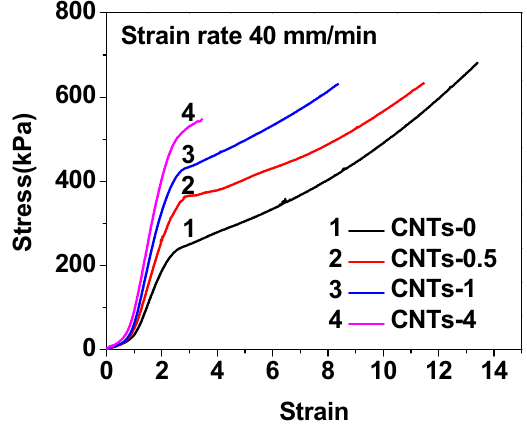
Figure 4. Tensile stress-strain curves of DN and nanocomposite DN hydrogels.